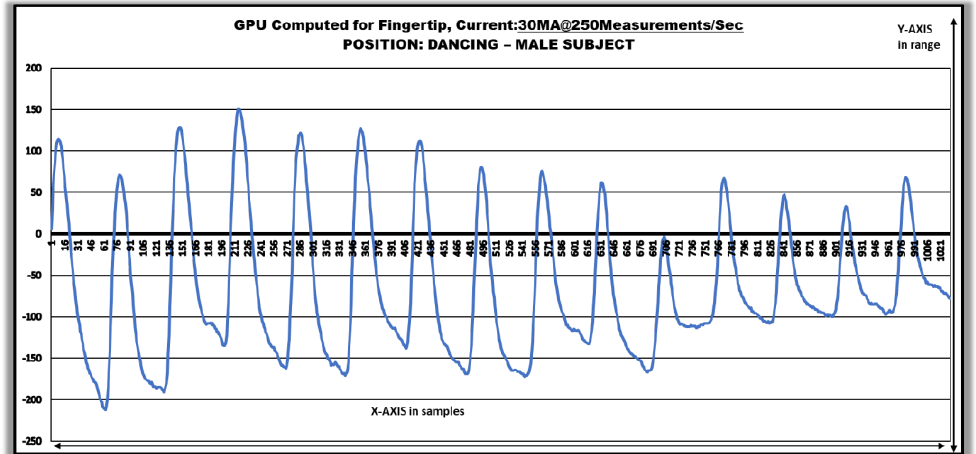
Figure 13. GPU-Computed Data using Fingertip: Observation Set E.